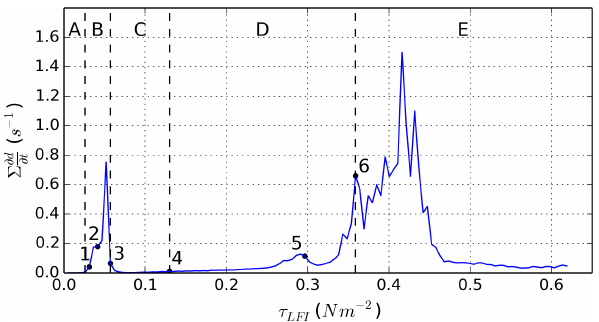
Figure 4. Time series of the domain-integrated brittle fracture ac- tivity ( ∂d/∂t ) for the control run simulation. Dashed lines indicate the beginning and end of the simulation phases (A, B, C, D, E), and numbers indicate the location of the damage field in Figs. 5 and